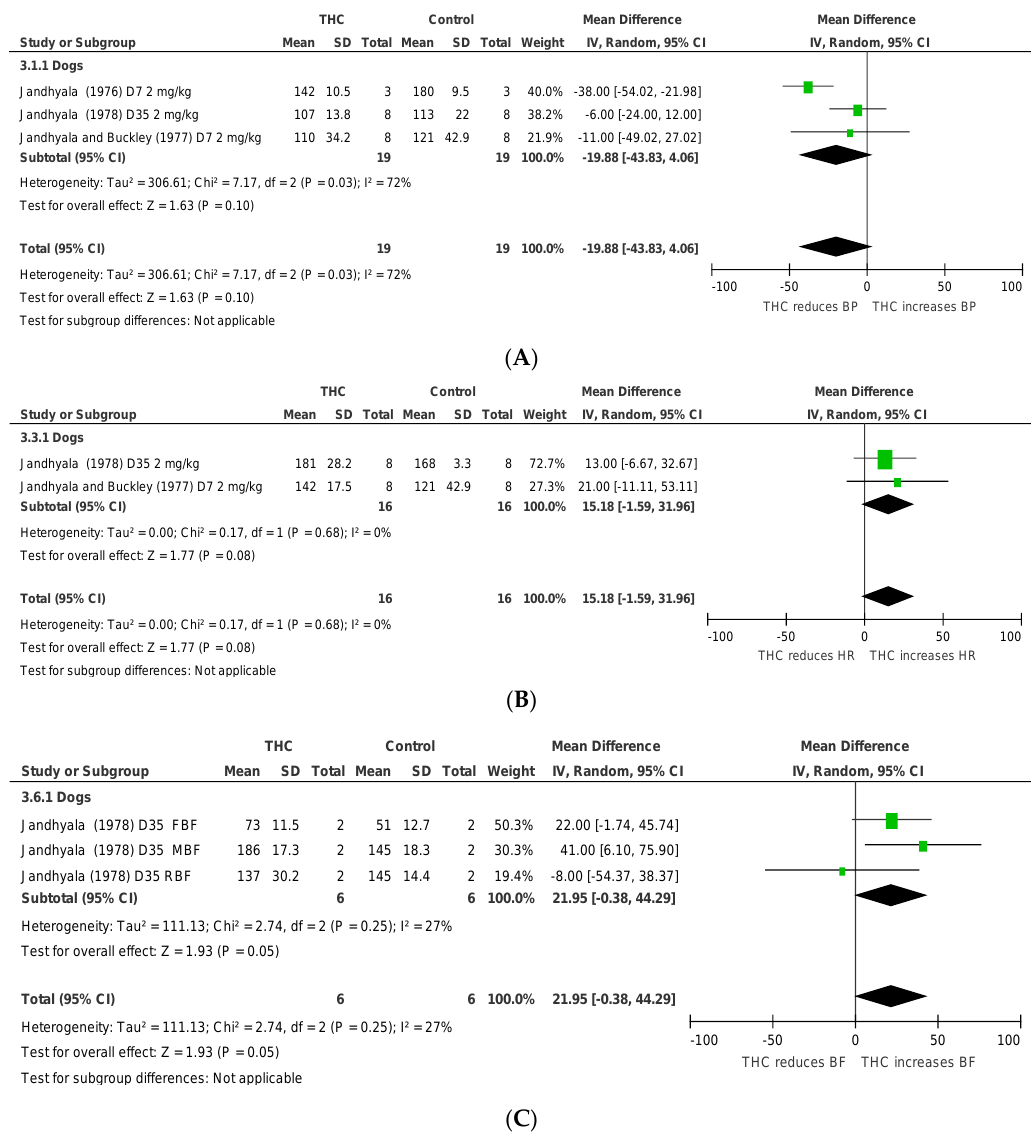
Figure 3. Changes in ( A ) blood pressure, ( B ) heart rate, and ( C ) blood flow (BF) induced by chronic THC dosing in anaesthetised animals.